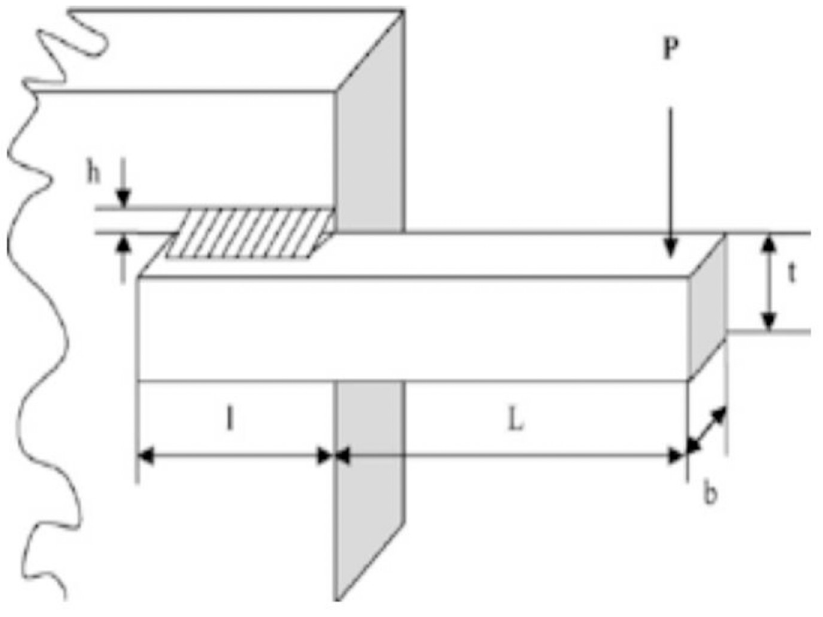
Fig 6. Design of WBD problem [28].